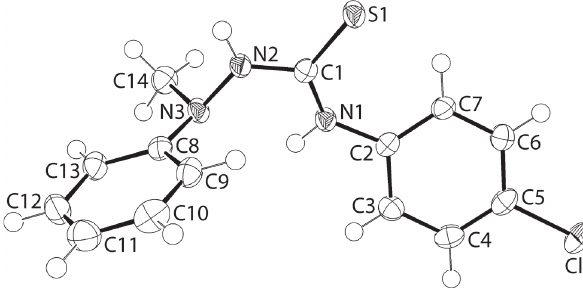
Table 1: Data collection and